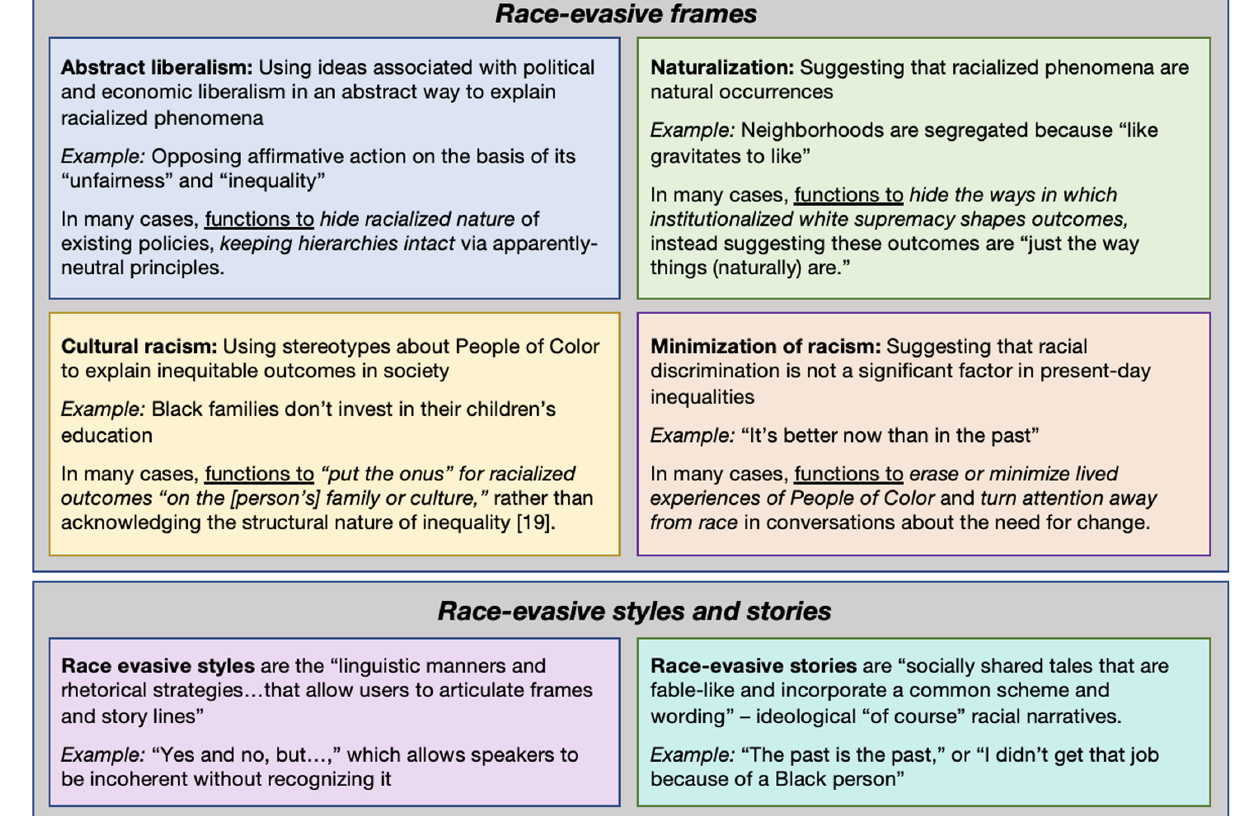
FIG. 1. Summary and examples of race-evasive frames. Image description: Graphic with two large gray rectangles, labeled “ race- evasive frames ” and “ race-evasive styles and stories, ” stacked on top of one another. In these large gray rectangles are smaller rectangles in a variety of colors, that describe the frames, styles, and stories of race-evasiveness and offer examples and descriptions of how the frames function. Text in the top left small rectangle reads “ Abstract liberalism: Using ideas associated with political and economic liberalism in an abstract way to explain racialized phenomena. Example: Opposing affirmative action on the basis of its ‘ unfairness ’ and ‘ inequality. ’ In many cases, functions to hide racialized nature of existing policies, keeping hierarchies intact via apparently-neutral principles ” . Text in the top right small rectangle reads: “ Naturalization: Suggesting that racialized phenomena are natural occurrences. Example: Neighborhoods are segregated because ‘ like gravitates to like. ’ In many cases, functions to hide the ways in which institutionalized white supremacy shapes outcomes, instead suggesting these outcomes are ‘ just the way things (naturally) are. ’ ” Text in the middle left small rectangle reads: “ Cultural racism: Using stereotypes about People of Color to explain inequitable outcomes in society. Example: Black families do not invest in their children ’ s education. In many cases, functions to ‘ put the onus ’ for racialized outcomes ‘ on the [person ’ s] family or culture, ’ rather than acknowledging the structural nature of inequality [19] ” . Text in the middle right small rectangle — the final small rectangle in the “ race-evasive frames ” rectangle — reads, “ Minimization of racism: Suggesting that racial discrimination is not a significant factor in present-day inequalities. Example: ‘ It ’ s better now than in the past. ’ In many cases, functions to erase or minimize lived experiences of People of Color and turn attention away from race in conversations about the need for change ” . In the “ race-evasive styles and stories ” rectangle are two smaller boxes. The box on the left includes text that reads, “ Race- evasive styles are the linguistic manners and rhetorical strategies … that allow users to articulate frames and story lines. ’ Example: ‘ Yes and no, but … , ’ which allows speakers to be incoherent without recognizing it ” . The box on the right includes text that reads, “ Race- evasive stories are ‘ socially shared tales that are fable-like and incorporate a common scheme and wording ’— ideological ‘ of course ’ racial narratives. Example: ‘ The past is the past, ’ or ‘ I didnot get that job because of a Black person. ’